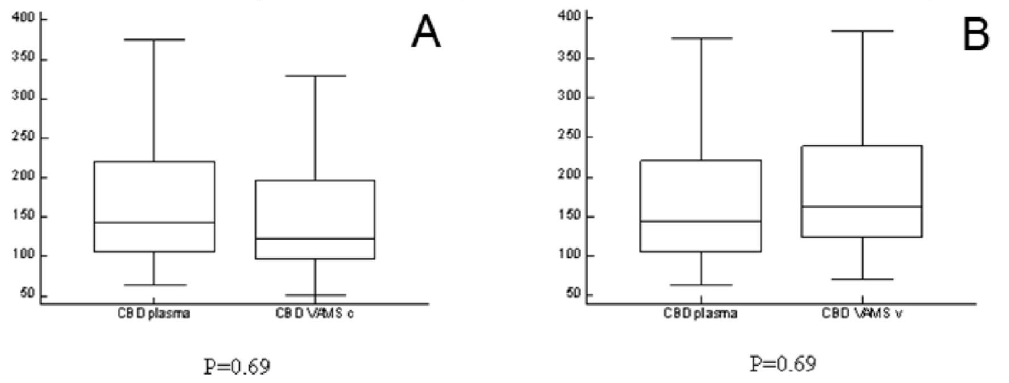
Figure 2. Mann Whitney tests of VAMS from capillary versus venous blood (Panel A ) and VAMS from capillary blood versus plasma (Panel B ).